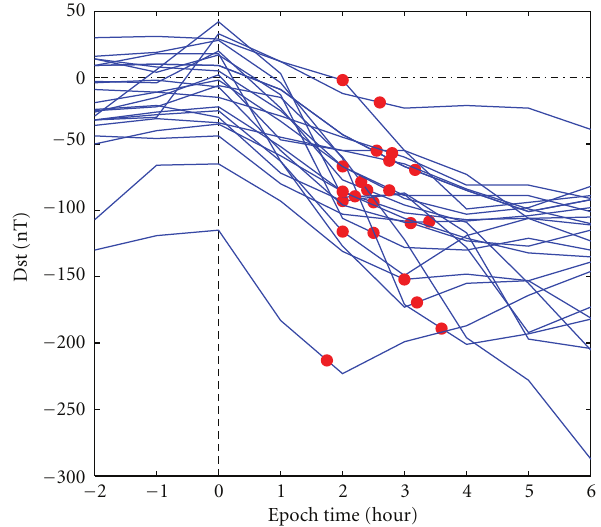
Figure 5: Epoch analysis of the Dst index during 22 intense magnetic storms. The dot in each storm case represents the time of the first detection of equatorial plasma density depletions (plasma bubbles) by a DMSP satellite in the evening